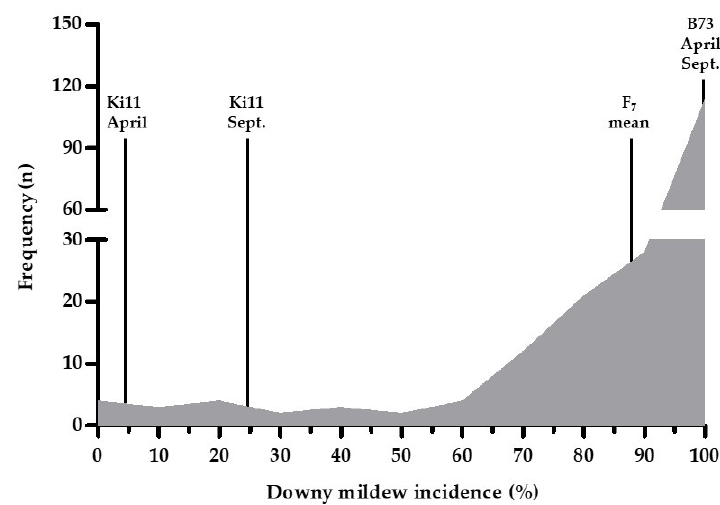
Figure 1. Frequency distribution of the F 7 families derived from B73 (susceptible) × Ki11 (resistant) based on downy mildew (DM) incidence in Phnom Penh, Cambodia in September 2017. The x -axis indicates the frequency of DM incidence in F 7 families. Ki11 and B73 were evaluated in April and September 2015. Table 2. Statistical data for DM experiments conducted in Phnom Penh, Cambodia in September 2017.